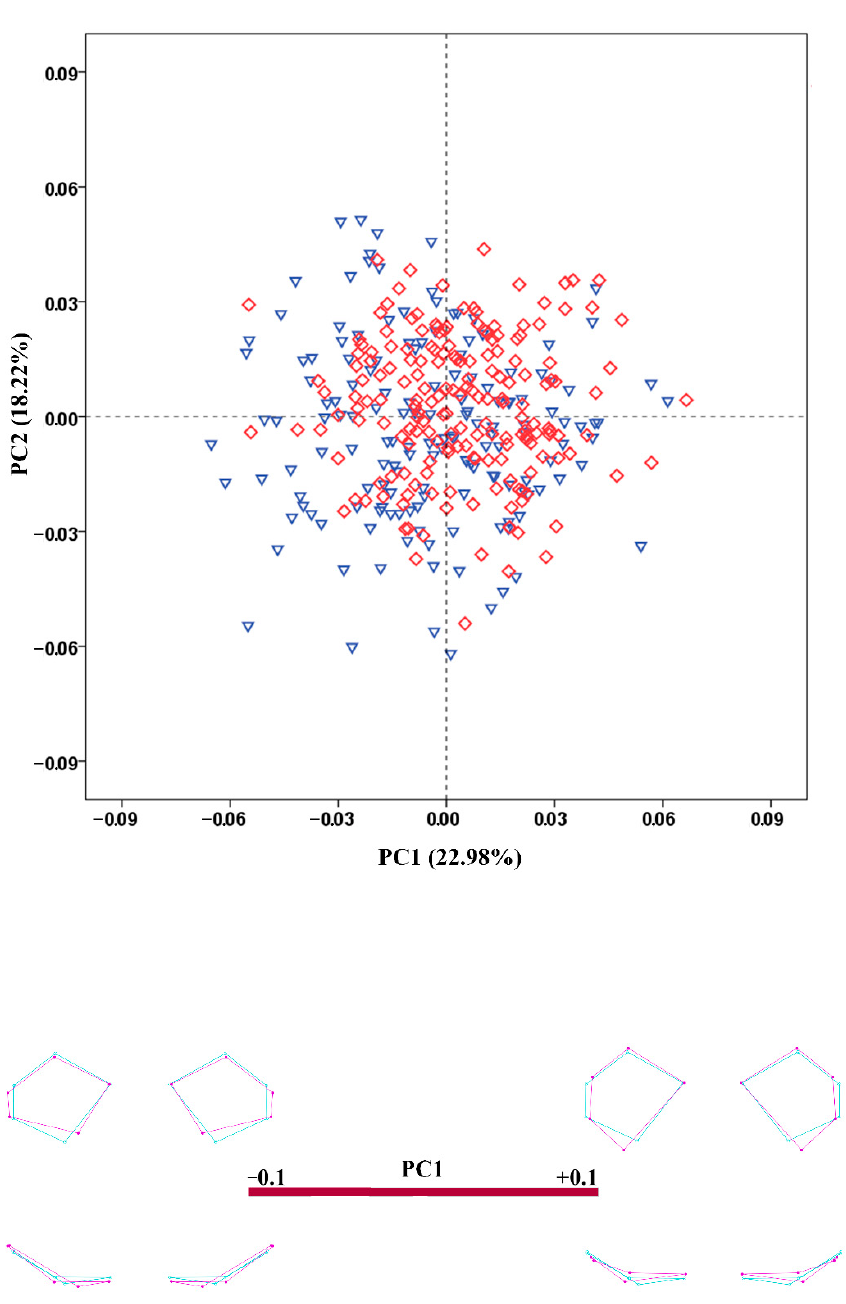
Figure 4. PCA scatterplot for the configuration of the orbital region. The wireframes illustrate the shape variation along the axis of PC1. Male crania—blue triangles; female crania—red rhombs; extreme shape configurations—purple wireframes; mean shape configuration—light blue wireframe.